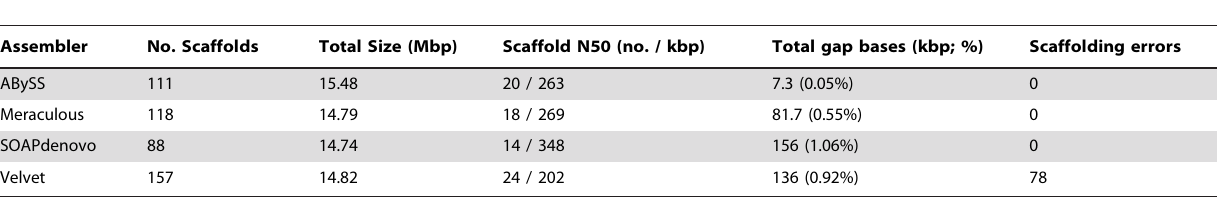
Table 2. Comparison of P. Stipitis assembly scaffold characteristics (including scaffolds of size at least 2 kbp).